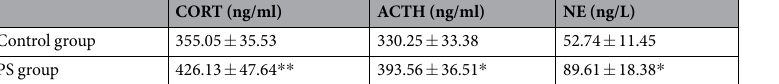
Table 1. Serum concentrations of CORT, ACTH and NE levels in rats of PS and control groups. Values are means ± S.D, n = 10. ** p < 0.01; * p < 0.05 vs control